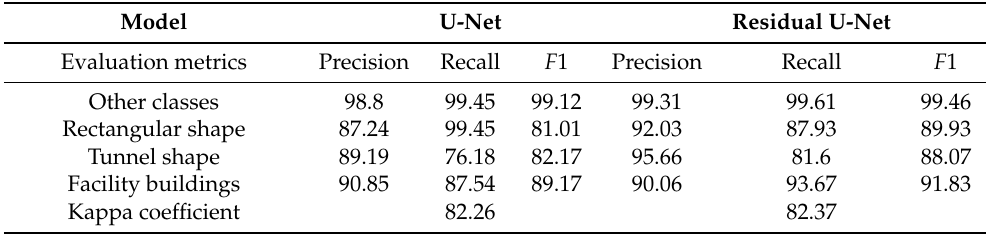
Figure 7. Resulting normalized confusion matrices for: ( a ) the U-Net; and ( b ) the Residual U-Net. Table 1. Dwelling classification results for the testing image patches for both trained network architectures of the U-Net and the residual U-Net. Accuracies are stated as percentages of precision, recall, F 1, and kappa